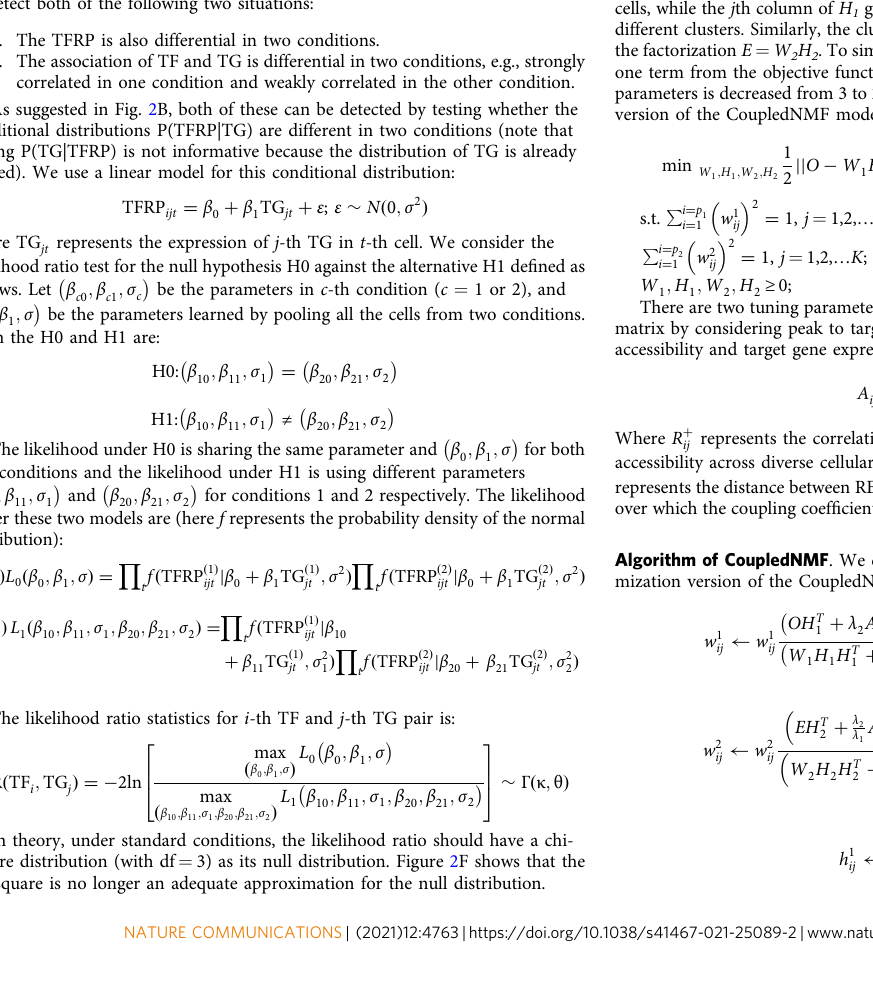
Fig. 5 Identi fi cation of TOX2 as a tumor-speci fi c regulator. A Out-degree of TFs in differential networks. Common network consistent of edges that are differential in all the three networks. B Visualization of B7 speci fi c differential network. The orange node represents TF, and the blue node represents non- TFs. The size of the node re fl ects the out-degree of the node. C t-SNE plot shows the expression of TOX2 in the healthy donor (left) and CLL donor (right). Red dots represent TOX2 expressed cells. D Track plot show cluster-speci fi c peaks near TOX2. E Comparison of TOX motif binding REs ’ accessibility on different B cell subpopulations by Metagene plot. The central line represents the mean of accessibility, and the ribbon represents the minimum and maximum of average accessibility from 1000 times bootstrap analysis. F Comparison of TOX2 expression in B cell in independent CLL and healthy control study. The central mark indicates the median, the bottom and top edges of the box indicate lower and upper quartiles, the whiskers extend to the most extreme data points not considered outliers, and the outliers are plotted individually using the ‘ + ‘ symbol. We use a one-tailed two-sample t -test and the p - value without multiple testing adjustment is 0.0013. G Fisher ’ s exact test shows TOX2 target genes are enriched in B7 speci fi c genes (compared to healthy control). H GO enrichment analysis for TOX2 target